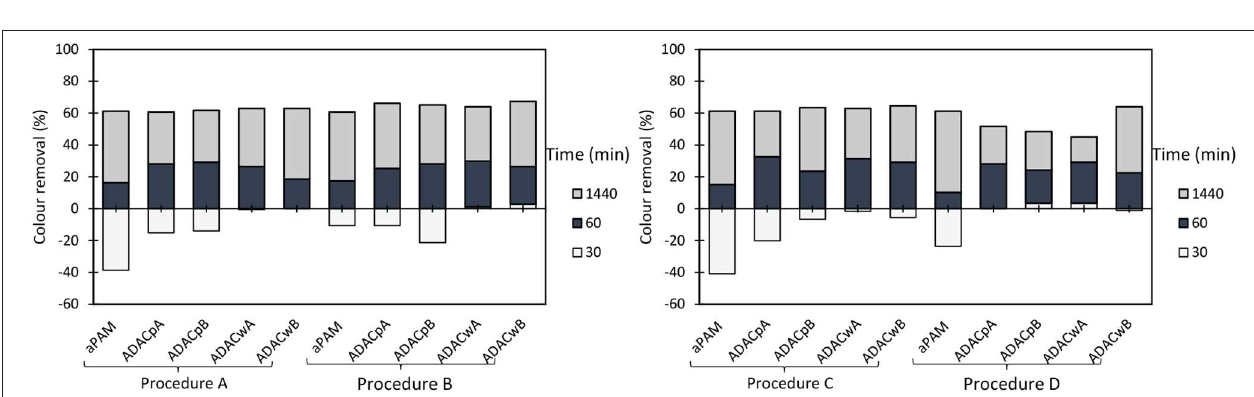
FIGURE 10 | Turbidity removal of industrial effluent as a function of time of settling, using anionic cellulose-based flocculation agents from bleached pulp (ADAC p A and B) and from wood chips (ADAC w A and B), in a dual system with bentonite, at pH 7.0. Procedure A: 0.3 wt% bentonite followed by 2.67 mg/L of flocculant. Procedure B: 0.6 wt% bentonite and 5.34 mg/L of flocculant. Procedure C: 0.3 wt% bentonite and 5.34 mg/L of flocculant. Procedure D: 0.6 wt% bentonite and 2.67 mg/L of flocculant. An anionic synthetic aPAM (in a dual system with the same concentrations described in procedures A-D), was used as